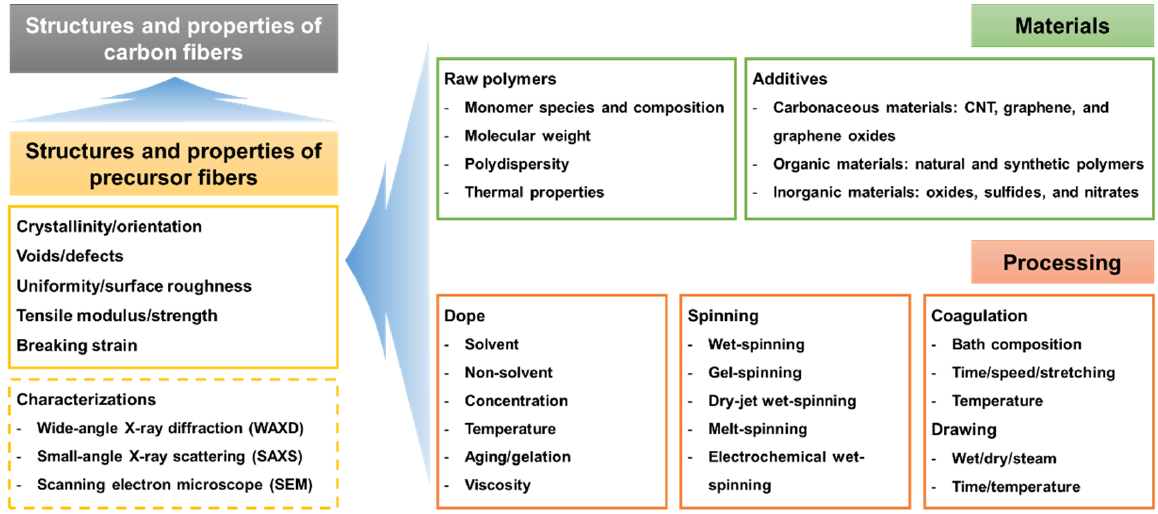
Figure 1. Overview of polyacrylonitrile (PAN) precursor fiber designing factors and characterization.